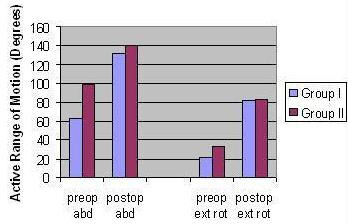
Preoperative and postoperative abduction (abd) and external rotation (ext rot) range of motion degrees of Group I and Group II patients.